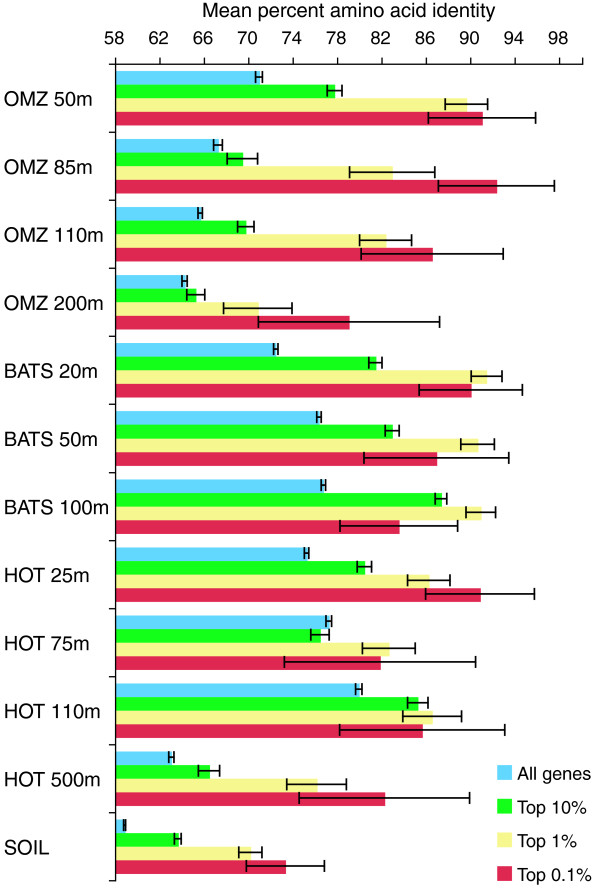
Sequence conservation increases with mRNA expression ratio. Genes are binned by rank expression ratio: all genes, top 10%, 1%, and 0.1% most highly expressed. Amino acid sequence identity is averaged across all DNA reads per gene (HSP alignment regions only), and then across all genes per bin. Error bars are 95% confidence intervals.